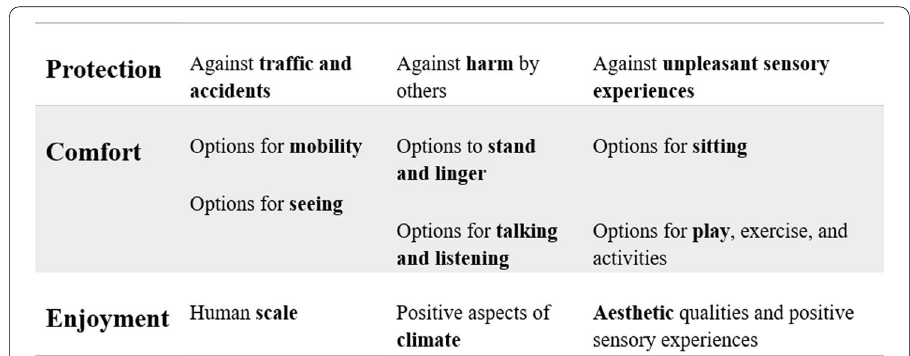
Fig. 1 12 criteria for qualitative public space (extracted from Gehl and Svarre 2013: